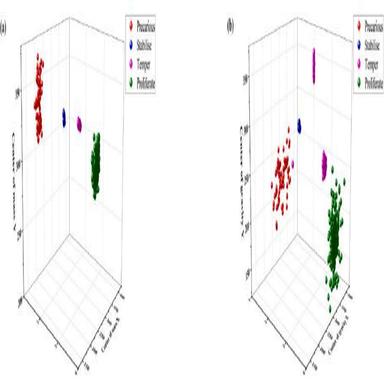
Center of mass and center of gravity for different flame types. (a) Centre of mass; (b) Center of gravity.